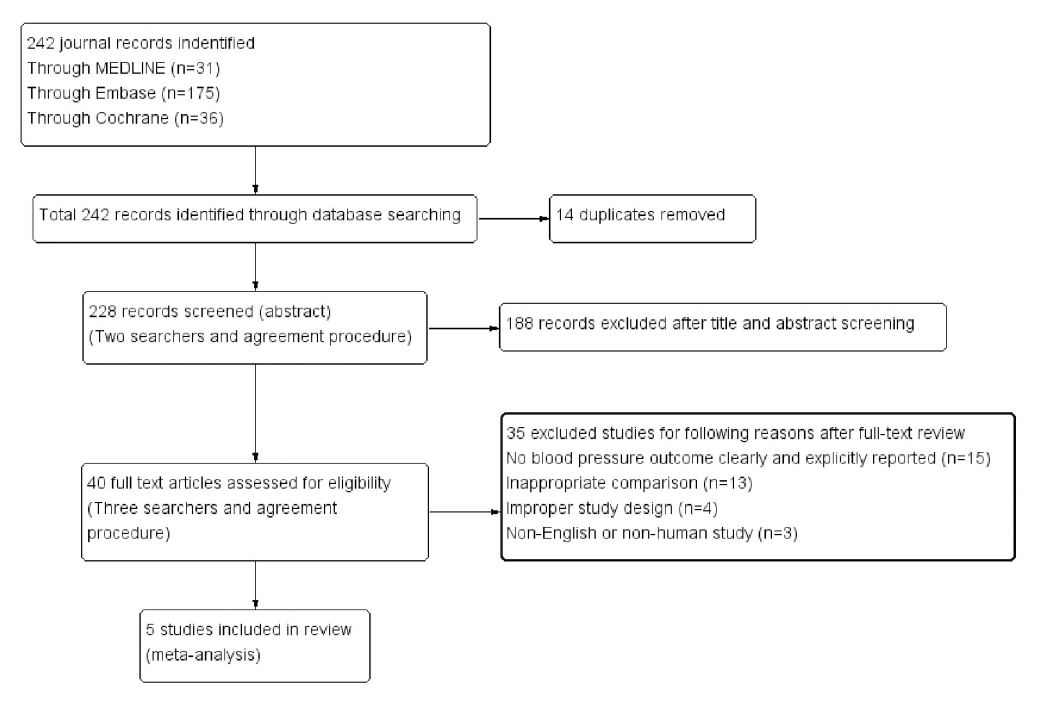
Fig 1. Preferred Reporting Items for Systematic Reviews and Meta-Analyses (PRISMA) flow diagram of study selection.